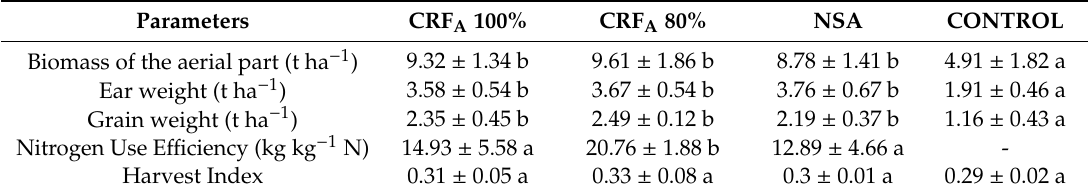
Table 4. Field harvest comparison of the growth parameters and grain yield of Triticum spelta among the di ff erent applied fertilizer treatments CRF A 100%, CRF A 80%, and NSA compared to the Control. Values are means ± SD ( n = 10) at the end of the culture—90 days after applying fertilizers.